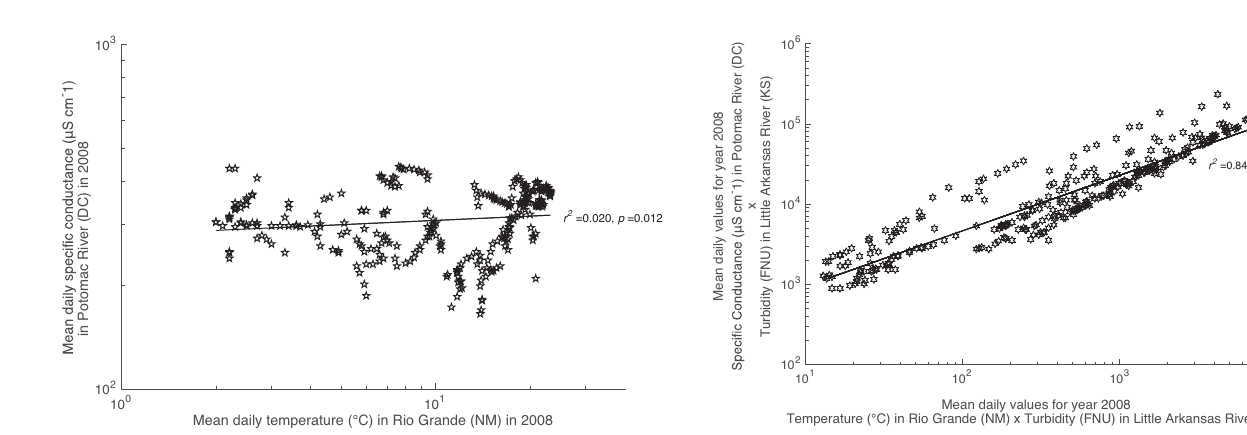
Figure 3. Synthetic data correlation, type X 1 vs. X 3 , without com- mon parameter, X 2 . There is a weak correlation between these water quality parameters.